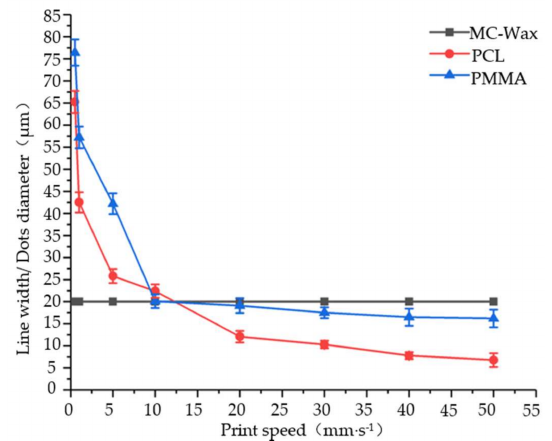
Figure 7. E ff ect of print speed on line width and diameter of the print